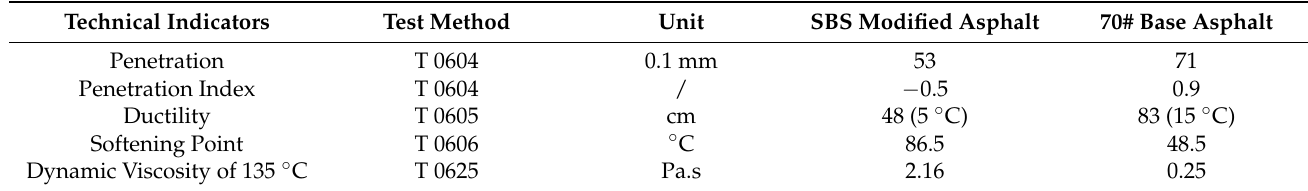
Table 1. The indexes of SBS-modified asphalt and 70# base asphalt.